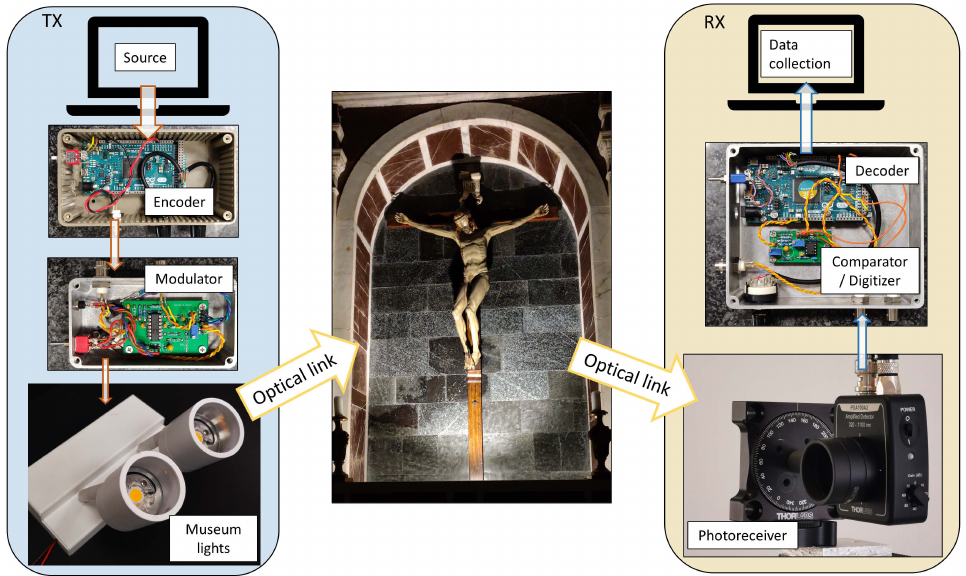
Figure 2. Hardware blocks in our VLC system. Left part (TX): The transmitter block includes the same light source used in the museum, supplied with a current modulator controlled by a digital encoder. Right part (RX): the block includes a modified commercial photodetector, with tailored FoV, and a digital decoder based on Arduino